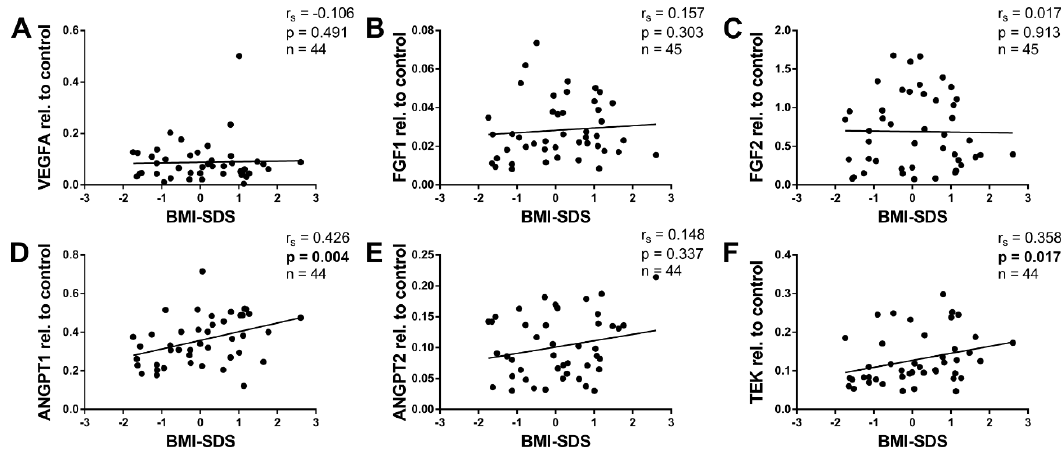
Figure 3. Association of angiogenic gene expression in pediatric WAT with BMI-SDS. Total RNA was isolated, reverse transcribed, and subjected to qPCR analysis using specific primer pairs as indicated. Respective gene expression was calculated as described in Methods and plotted against BMI-SDS. ( D , F ) ANGPT1 and the receptor TEK correlated positively with BMI-SDS. ( A , B , C, and E ) In contrast, VEGFA, FGF1, FGF2, and ANGPT2 showed no significant correlation. Spearman correlation coefficient r s and p value, as well as number of subjects, are given in each scatter plot. Significant p values ( p < 0.05) are indicated in bold. Trend lines were calculated as linear regressions.